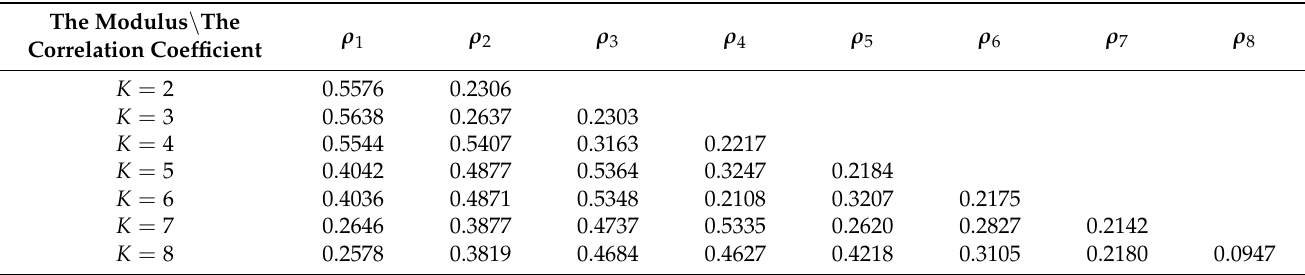
Table 2. Correlation coefficient between each mode and the original signal when the bearing inner ring faults with different K values.